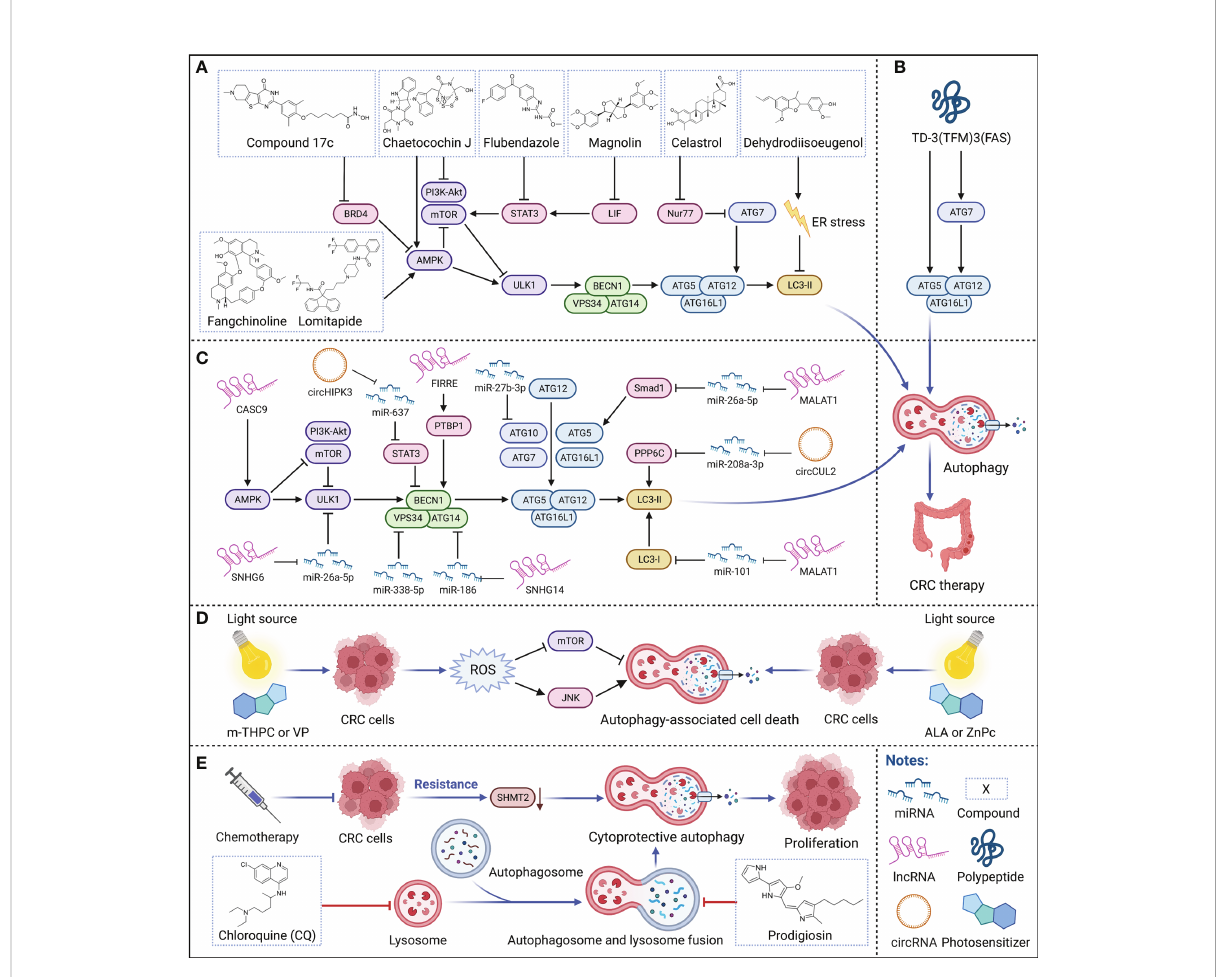
FIGURE 2 Therapeutic strategies targeting autophagy for CRC therapy. (A – C) Small-molecule compounds, polypeptide, and ncRNAs for targeting autophagy in CRC therapy. Various small-molecule compounds, the polypeptide, and multiple ncRNAs modulate critical regulators of autophagy to treat CRC. (D) Photodynamic therapy targeting autophagy in CRC therapy. Multiple photosensitizers with speci fi c wavelength light source irradiation induce autophagy-associated cell death, participating in CRC therapy. (E) Adjuvant chemotherapy by autophagy for CRC therapy. Autophagy inhibitors can effectively suppress the cytoprotective autophagy triggered by long-term chemotherapy and restore the sensitivity of tumors to chemotherapy drugs, enhancing the effectiveness of